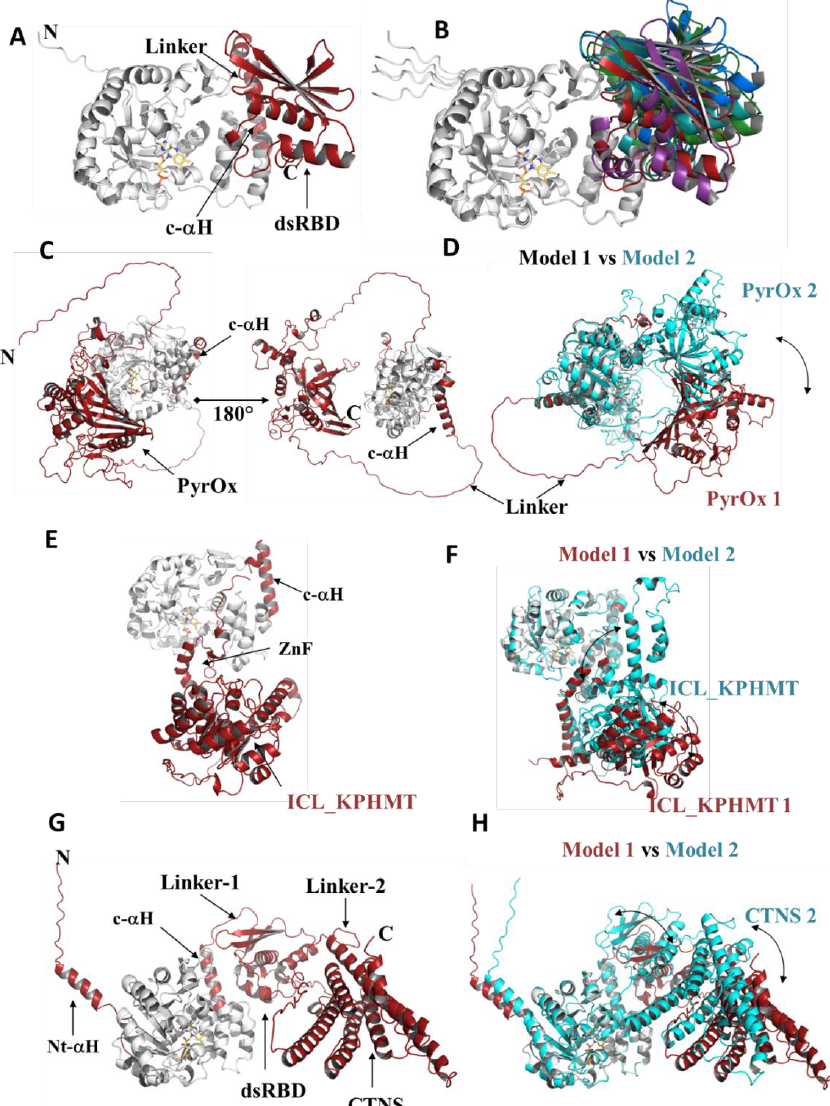
Figure 5. Modularity and domain orientation in Dus2. ( A ) Structural 3D model of A. queenslandica Dus2. The canonical domains are in gray while the c- α H and the dsRBD are in red. The linker attaching the c- α H to the dsRBD is indicated. ( B ) Structural superposition of the 5 A. queenslandica Dus2 model generated by AlphaFold2. The TIM-barrel and the HD of each model are in gray while the dsRBD are colored in a different color for each model. ( C ) Structural 3D model of M. pennsylcanicum Dus2 showing to different view that differs by a rotation of 180° around the z-axis. The canonical domains are in gray while the c- α H and PyrOx domains are in red. ( D ) Structural superposition of models 1 and 2 of M. pennsylcanicum Dus2 generated by AlphaFold2. Model 1 is colored as indicated in ( C ) while model 2 is in cyan. The double-headed arrow indicates the different orientation of the PyrOx domain in the two models. ( E ) Structural 3D model of P. insidiosum Dus2. The canonical domains are in gray while the c- α H, the ZnFD, and the ICL-KPHMT domains are in red. ( F ) Structural superposition of models 1 and 2 of P. insidiosum Dus2 generated by AlphaFold2. Model 1 is colored as indicated in ( E ) while model 2 is in cyan. The double-headed arrows indicate the difference in orientation of the ZnFD and ICL-KPHMT domains in the two models. ( G ) Structural 3D model of T. nelsoni Dus2. The canonical domains are in gray while the c- α H, the dsRBD, and the CTNS domains are in red. ( H ) Structural superposition of models 1 and 2 of T. nelsoni Dus2 generated by AlphaFold2. Model 1 is colored as indicated in ( G ) while model 2 is in cyan. The double-headed arrows indicate the respective difference in orientation of the dsRBD and CTNS domains in the two